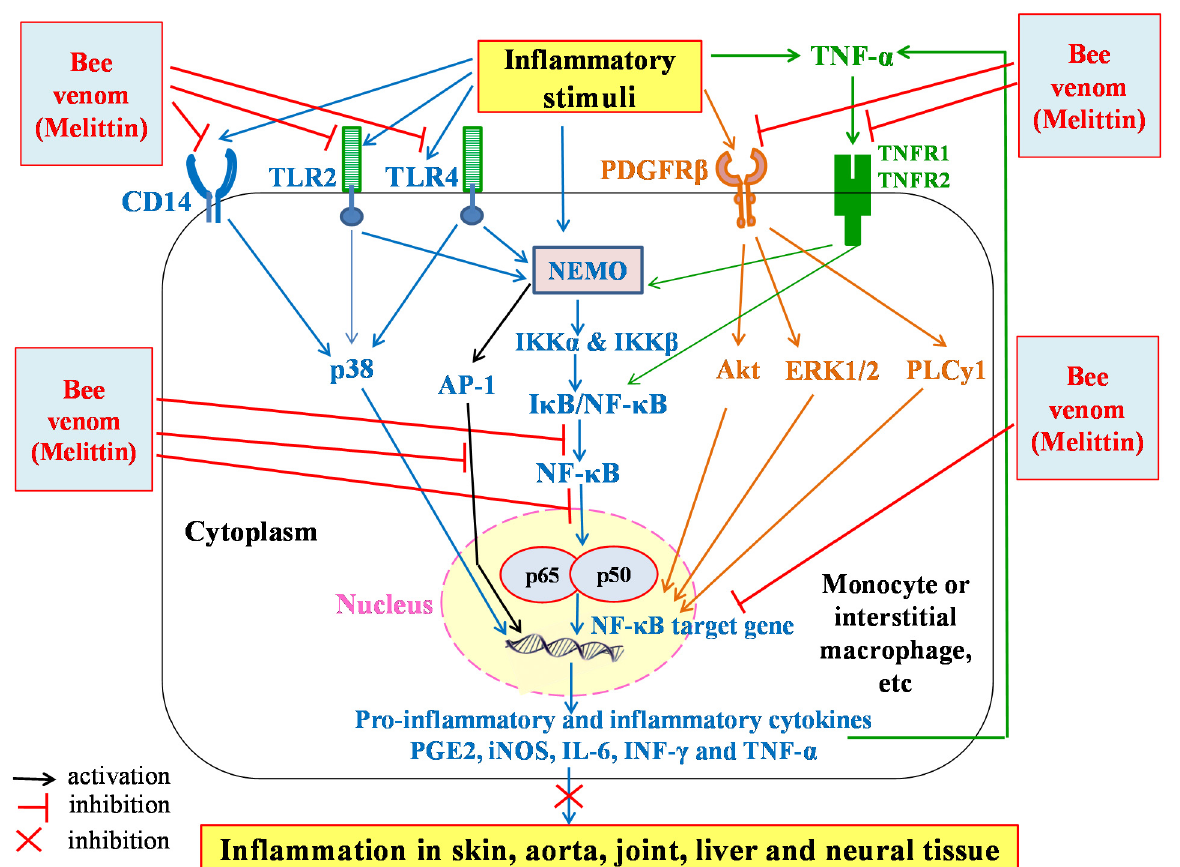
Figure 2. Schematic figure showing the proposed anti-inflammatory mechanisms of action of bee venom and melittin. NF- κ B, nuclear factor- κ B; I κ B, inhibitor of NF- κ B; I κ B/NF- κ B, I κ B-NF- κ B complex; IKK α , I κ B kinase α ; IKK β , I κ B kinase β ; NEMO, NF- κ B essential modulator; TLR, Toll-like receptor; CD, cluster of differentiation; PDGFR β , platelet-derived growth factor receptor beta; AP-1, activator protein 1.